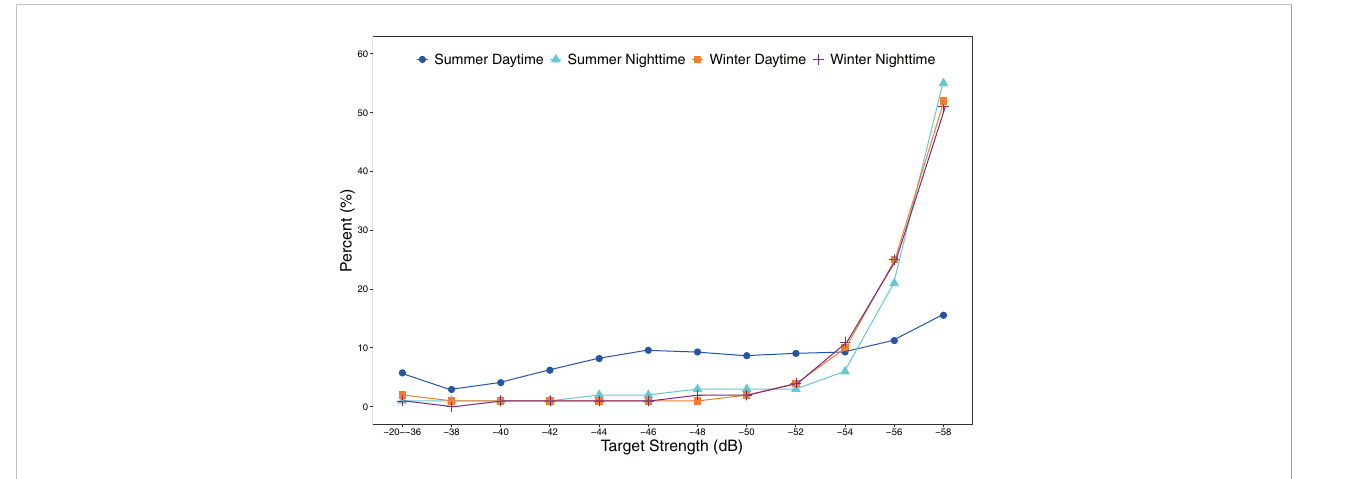
FIGURE 5 Fish TS distribution from four hydroacoustic surveys in Yudong